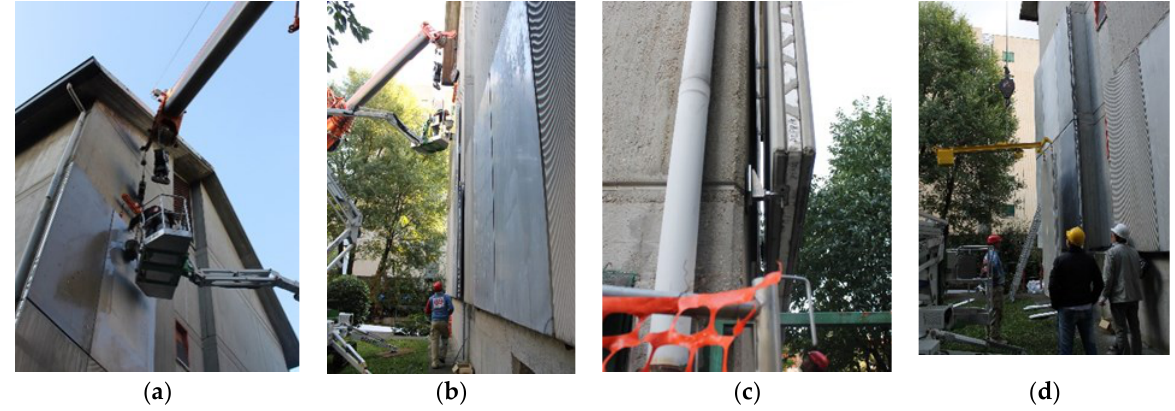
Figure 13. Steps of panel installation process and technical details: ( a ) lifting by crane; ( b ) assembly in parallel to the line of the façade via a rocker; ( c ) positioning through inclusion in the boxes of the façade; ( d ) covering panels ’ positioning with a crane.